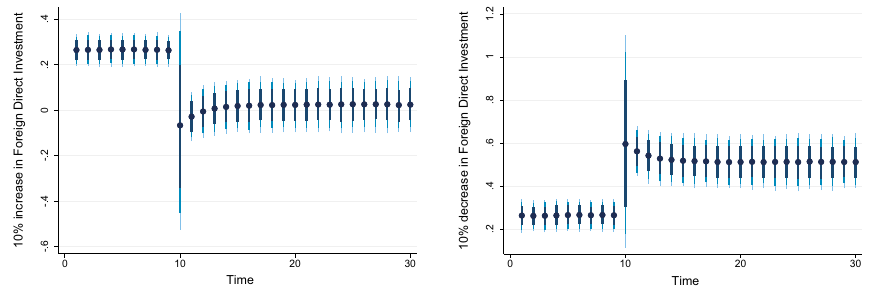
Fig. 5 The Impulse Response Plot for Foreign Direct Investment and CO 2 Emissions. Figure 5 presents an increase and a decrease by 10% in foreign direct investment and its effect on CO 2 emissions where dots denote average prediction value. The dark blue to light blue line shows 75, 90, and 95% confidence interval,